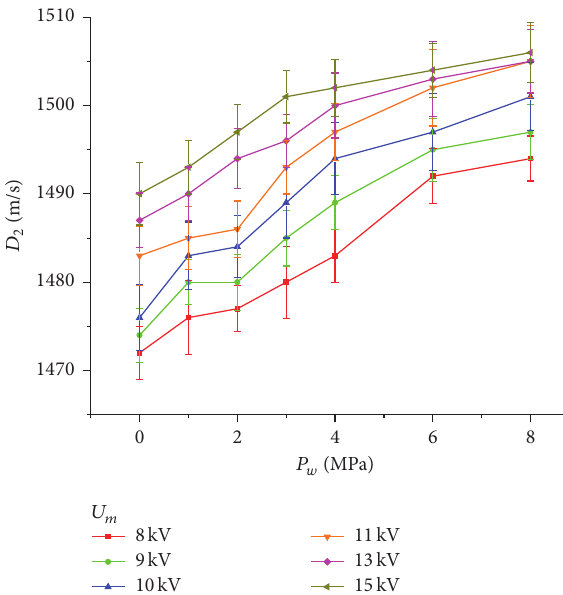
Figure 16: Reflection shock wave velocity ( 𝐷 2 ) at 2.5 m from the